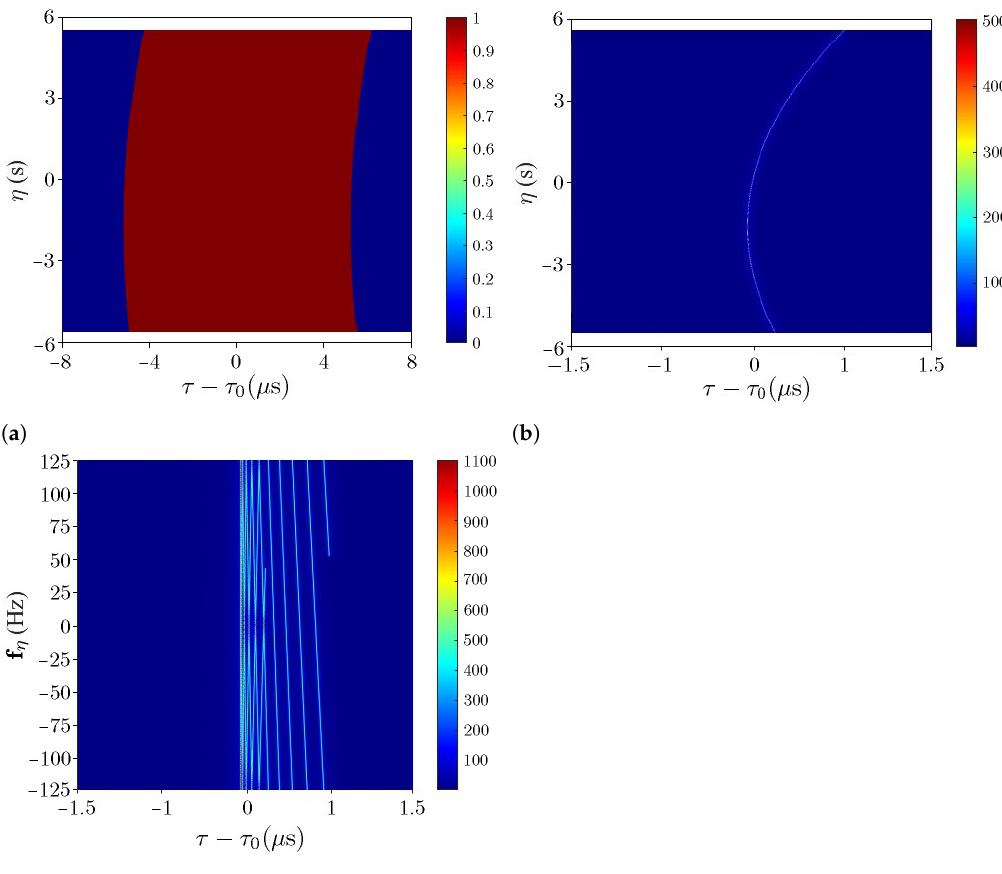
( τ , η ) , received signal after demodulation, ( b ) s q 1 b ( τ , f η ) , wrapped Doppler spectrum, with τ 41